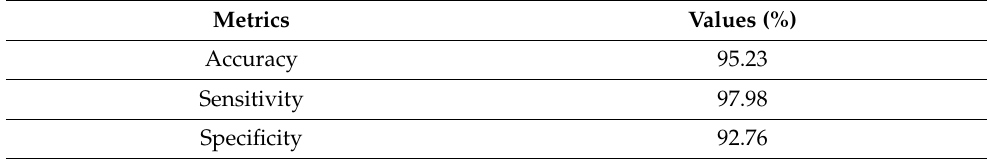
Table 2. Accuracy, Sensitivity, and Specificity of the bagging ensemble